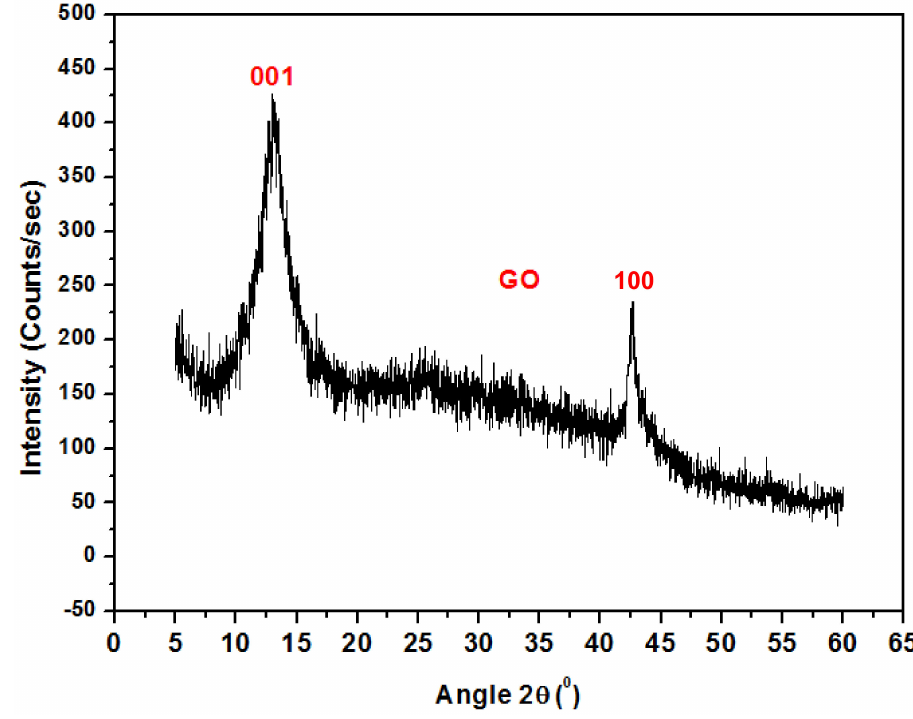
Figure 3. XRD pattern of Graphene